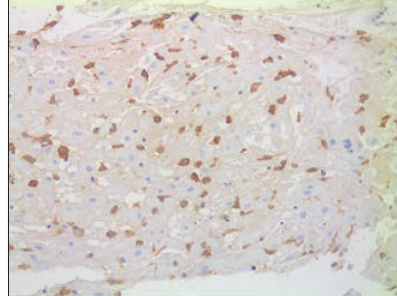
Fig. 4. DC-SIGNR expression in decidual